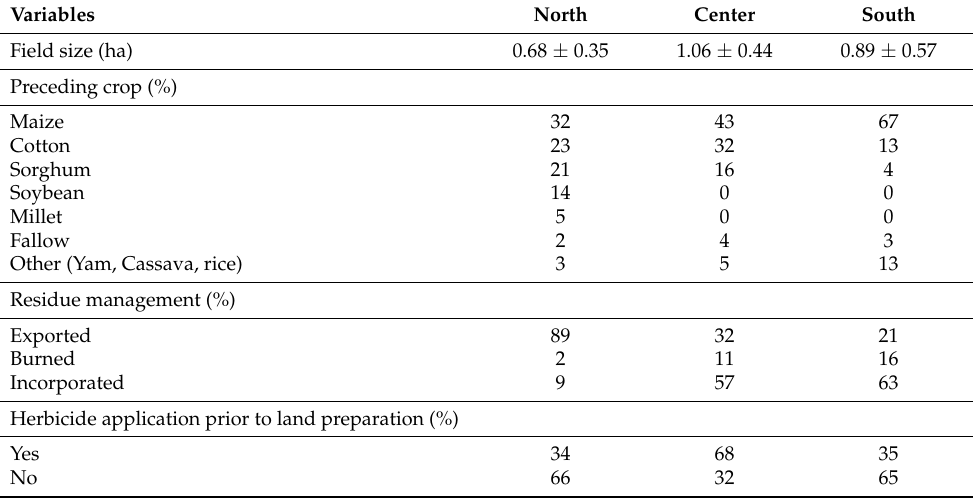
Table 2. Cowpea cultivation practices from north to south of Benin. Means ± standard deviations are displayed for continuous variables while proportions are displayed for categorical